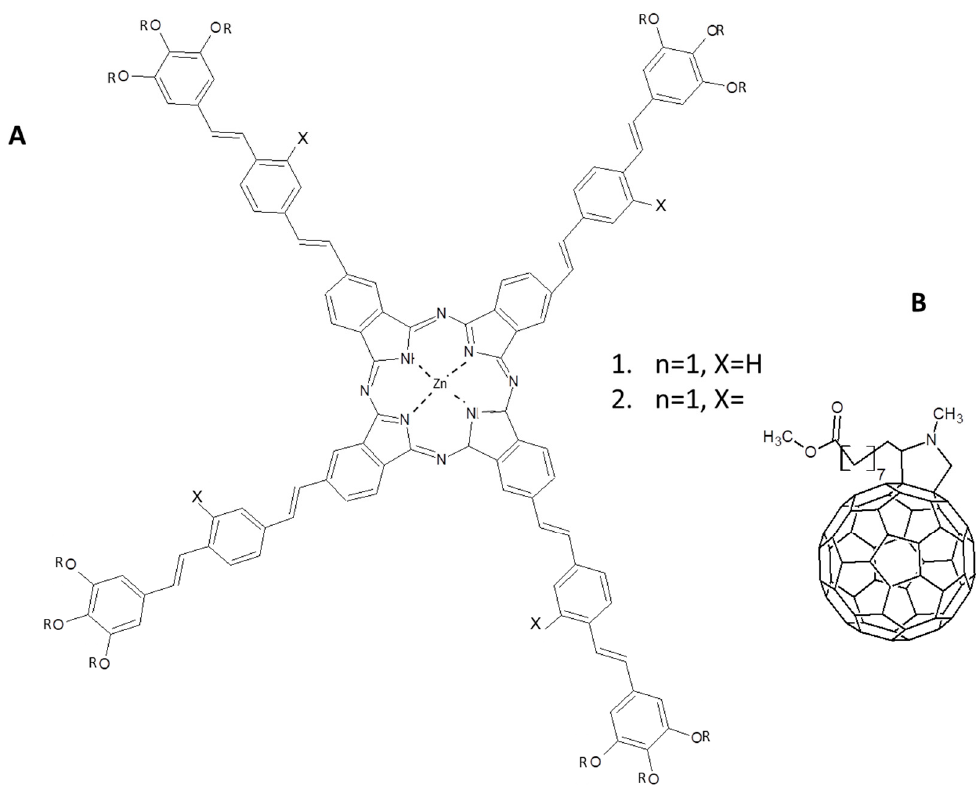
Figure 15. ( A ) Star-shaped zinc phthalocyanines and ( B ) fulleropyrrolidine derivative chemical structures used in [99].